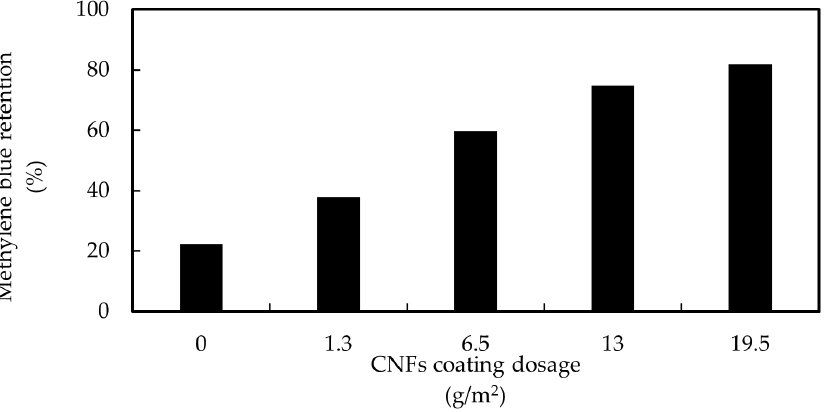
Figure 5. Methylene blue retention of a pristine UF membrane and coated by different CNFs dosages.